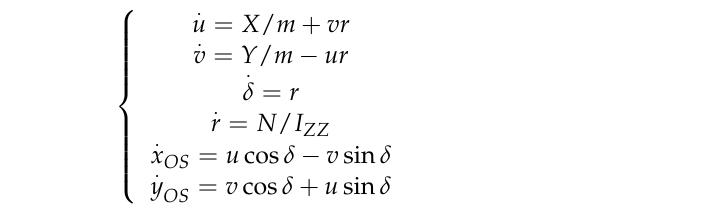
Figure 2. The coordinate systems of the MASS. The X e O e Y e represents the geodetic coordinate system. The X b O b Y b represents the horizontal ship body-fixed coordinate system. G is the center of ship gravity, u is longitudinal velocity, v is lateral velocity, δ is yaw angle, and r is the yaw angular velocity.